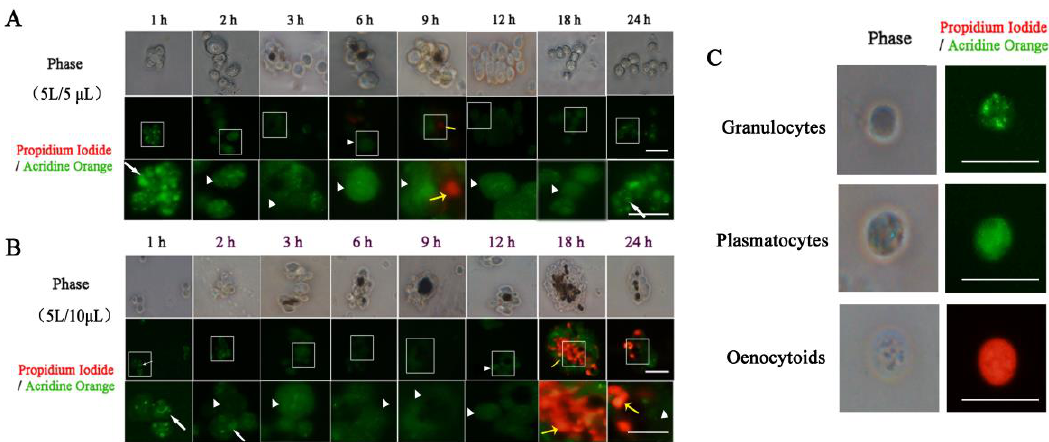
Figure 5. Morphology types of hemocytes using fluorescence microscopy. ( A ) 5 L / 5 µ L and ( B ) 5 L / 10 µ L refer to the fifth instar larvae injection of 5 and 10 µ L E. coli , respectively. One, 2, 3, 6, 9, 12, 18 and 24 h represent the times after injection bacteria. The first line is the hemocyte morphology under white light, the second line is the hemocyte morphology under fluorescent light, and the third line is a local area magnification of hemocyte morphology corresponding with the second line in ( A ) and ( B ). The white boxes show the areas to zoom in on. The white arrow shows granulocytes containing bright green fluorescent granules. The white arrowhead shows plasmatocytes containing homogeneously faint green in the cytoplasm. The yellow arrowhead shows oenocytoids emitting red fluorescence (Ling et al., 2003). ( C ) Morphology of granulocytes, plasmatocytes and oenocytoids. The horizontal bar “ 一 ” represents 20 μm.